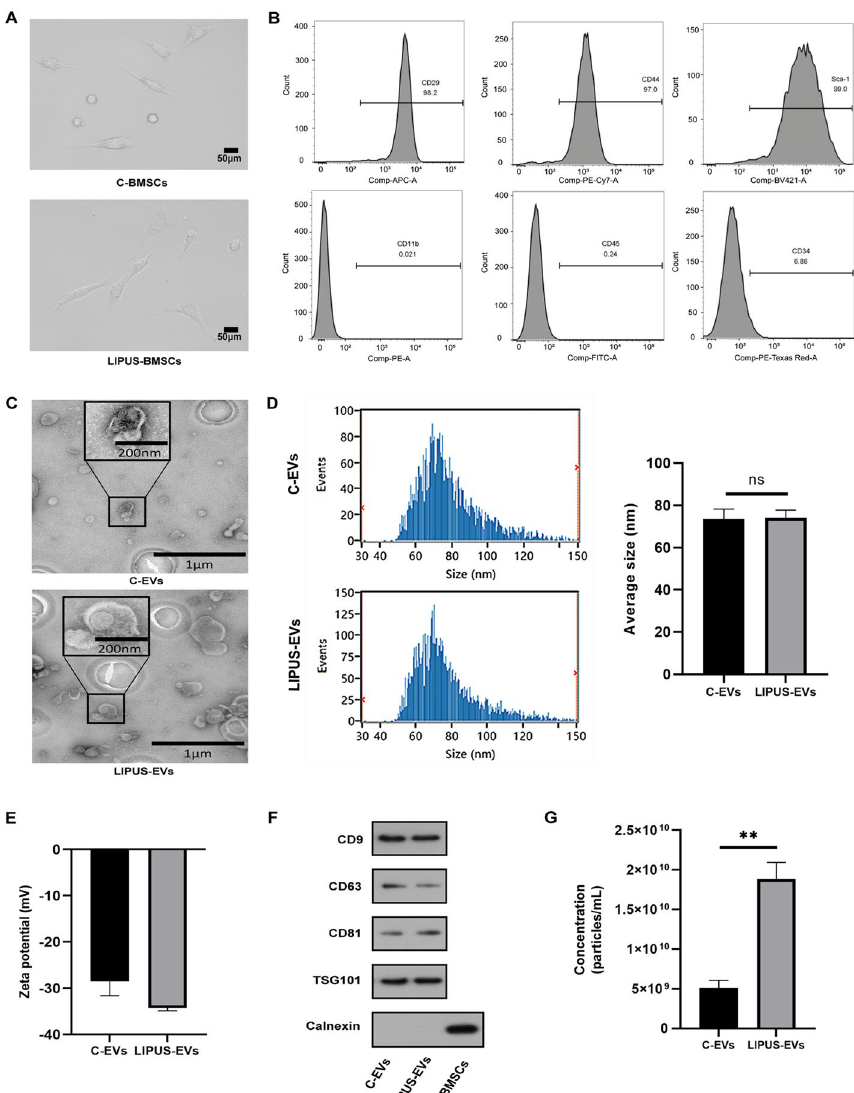
Fig. 1 Characterization of BMSCs and BMSCs-derived EVs. A BMSCs before and after LIPUS irradiation both displayed a representative spindle-like morphology. Scale bar: 50 μm. B Flow cytometry analysis of the cell surface markers on BMSCs. Cells were cultured in P5 or P6 and the results showed that BMSCs were positive for CD29, CD44 and Sca-1, but negative for CD11b, CD45 and CD34. C Morphology of C-EVs and LIPUS-EVs observed by TEM. Scale bar, 1 μm; inset scale bar, 200 nm. D Average size of BMSCs-derived EVs measured by NanoSight NTA. n 5 per group. E Zeta potential of C-EVs and LIPUS-EVs detected using ZetaView. n 3 per = = group. F The surface markers of BMSCs-derived EVs (CD9, CD63, CD81, TSG101 and Calnexin) were detected by western blotting. G Overall concentration of EVs by Nanosight NTA profiling revealing a significant increase in EVs following LIPUS exposure . ** p < 0.01 vs. Control. n 5 per group. Statistical significance = assessed by unpaired two-tailed t -test. EVs, extracellular